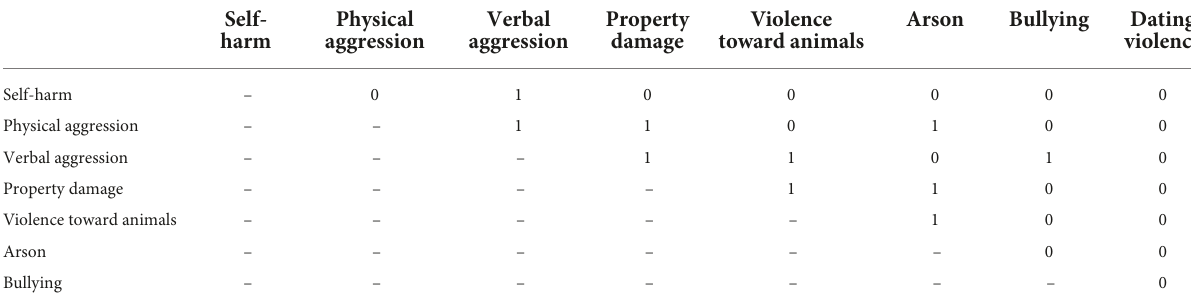
TABLE 2 Adjacency matrix for the network model examining interconnections between all the harmful behaviour variables. Self- Physical Verbal harm aggression